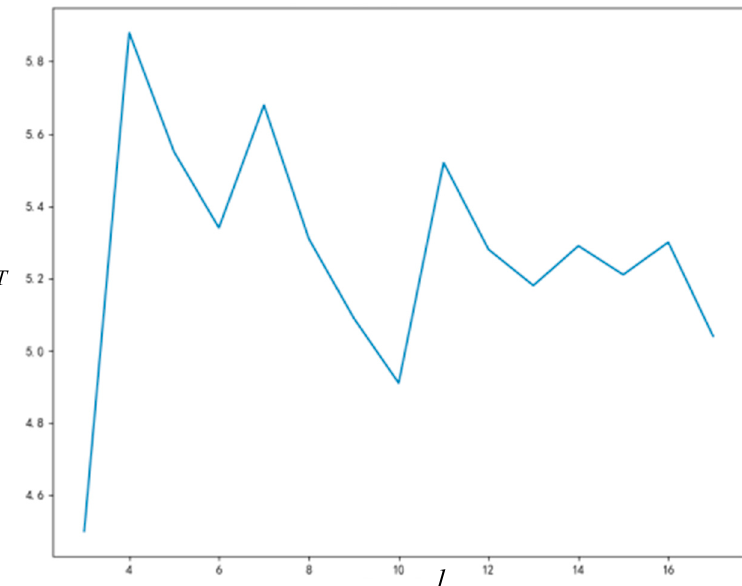
Figure 9. The relationship between node degree and T .